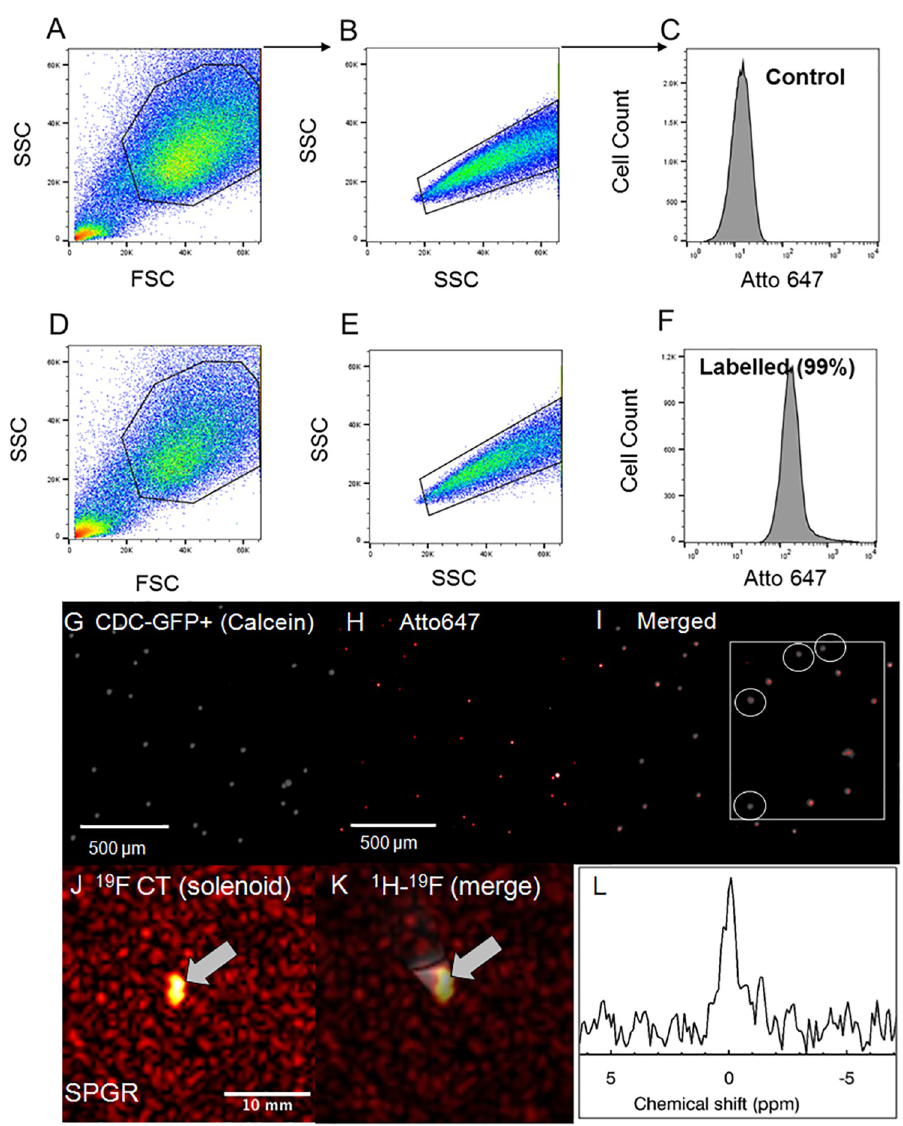
Fig 6. 19 F MRI-based quantification in solutions and CPCs and determination of cellular detectability limit. 19 F MR spectroscopy, image-based quantification, and sensitivity detection limits: (A, B) Axial 1 H and 19 F images from TFA phantoms of different concentrations (25–100 mM), and images of a multivial sensitivity phantom containing 0.25, 0.5, 0.75, and 1 million labeled/transfected CT cells suspended in media for sensitivity limit detection (cell pellets resided at the bottom of the Eppendorf tubes) using the butterfly coil. (C) 1 H imaging indicates spatial B 1 fall off-effects (laterally and with depth, non-adiabatic excitation). 19 F imaging indicates a minimum detectable cellular load of approximately 500k cells in a total acquisition of 4.4 min (white arrows). The 19 F MRI in (D) shows cells over a slice thickness of 20 mm. As shown by the inserted schematic, the 1 H MRI in (C) shows cross-sections (from the middle of the Eppendorf tubes), while the 19 F MRI in (D) shows the hyperintense cell pellets that were sometimes slightly displaced spatially given the tilting of some of the tubes and the dispersion of the cells on the walls of the tubes in instances where the acquisitions were prolonged. (E) Quantification of labelled CPCs using 19 F MRS (solenoid). The linearity of the evoked fully relaxed spectral area versus cell number was independently confirmed using fast, direct, image-based SPGR using CPCs (butterfly coil) (results not shown).